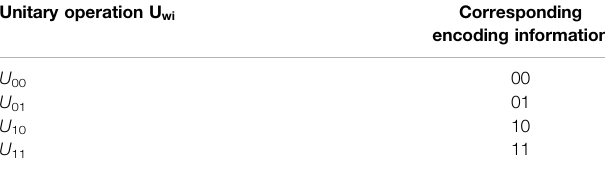
TABLE 1 | Encoding rules. Unitary operation U wi Corresponding